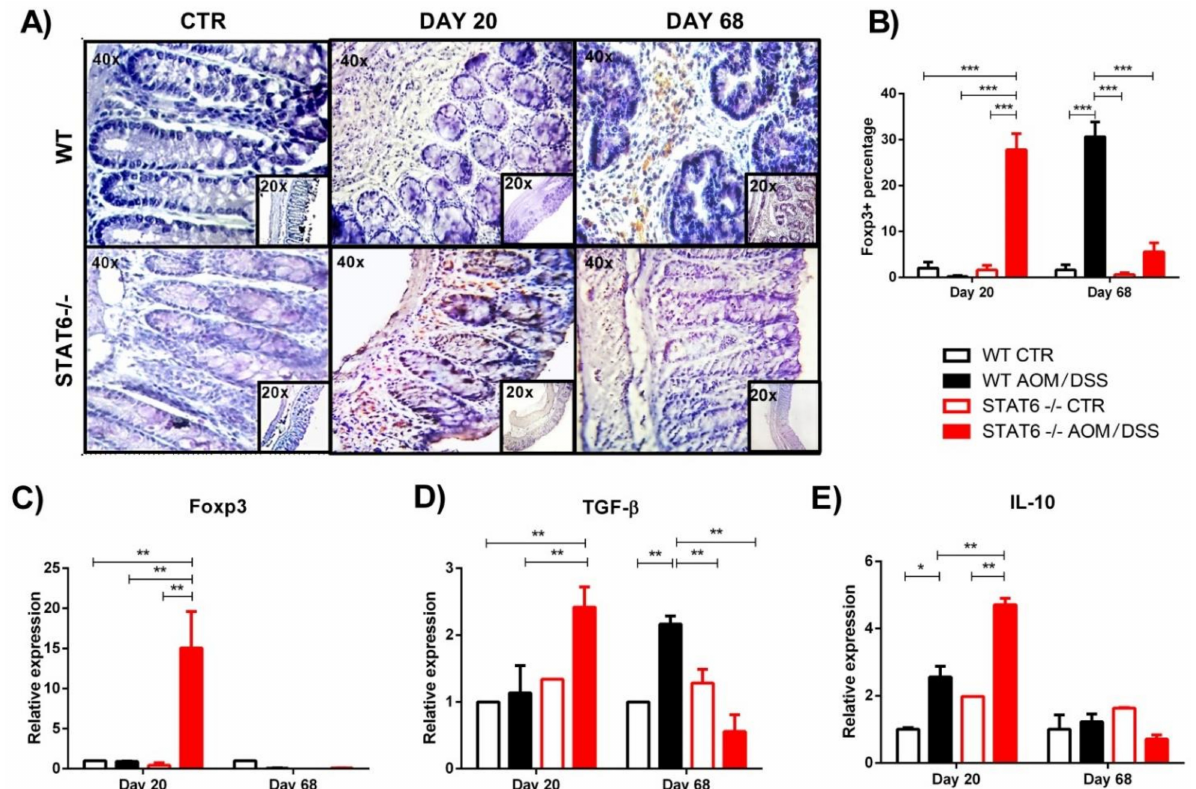
Figure 2. A more pronounced expression of the Foxp3 protein and mRNA in the colon of STAT6 − / − AOM/DSS-treated animals was observed during early CAC development. ( A ) A representative example of Foxp3 expression evaluated immunohistochemically in intestinal biopsies from the WT or STAT6 − / − AOM/DSS-treated or control mice at Day 20 and Day 68 of the AOM/DSS administration. The sections of tissue were analyzed at 20 × and 40 × using an optical microscope ( B ) The average percentages of Foxp3+ cells in the colon at Day 20. The quantification of Foxp3+ cells was performed using ImageJ software v.1.48 by counting cells in 10 high-powered fields, with at least three slides per animal. ( C – E ) The quantitative real-time PCR analysis of the colonic mRNA expression of Foxp3 ( C ), TGF- β ( D ), and IL-10 ( E ) in the WT or STAT6 − / − AOM/DSS-treated or control mice at Day 20 of the AOM administration. The data are expressed as the mean ± SEM and are representative of two independent experiments, with at least three mice per group per day of the analysis. * p < 0.05, ** p < 0.01, *** p <